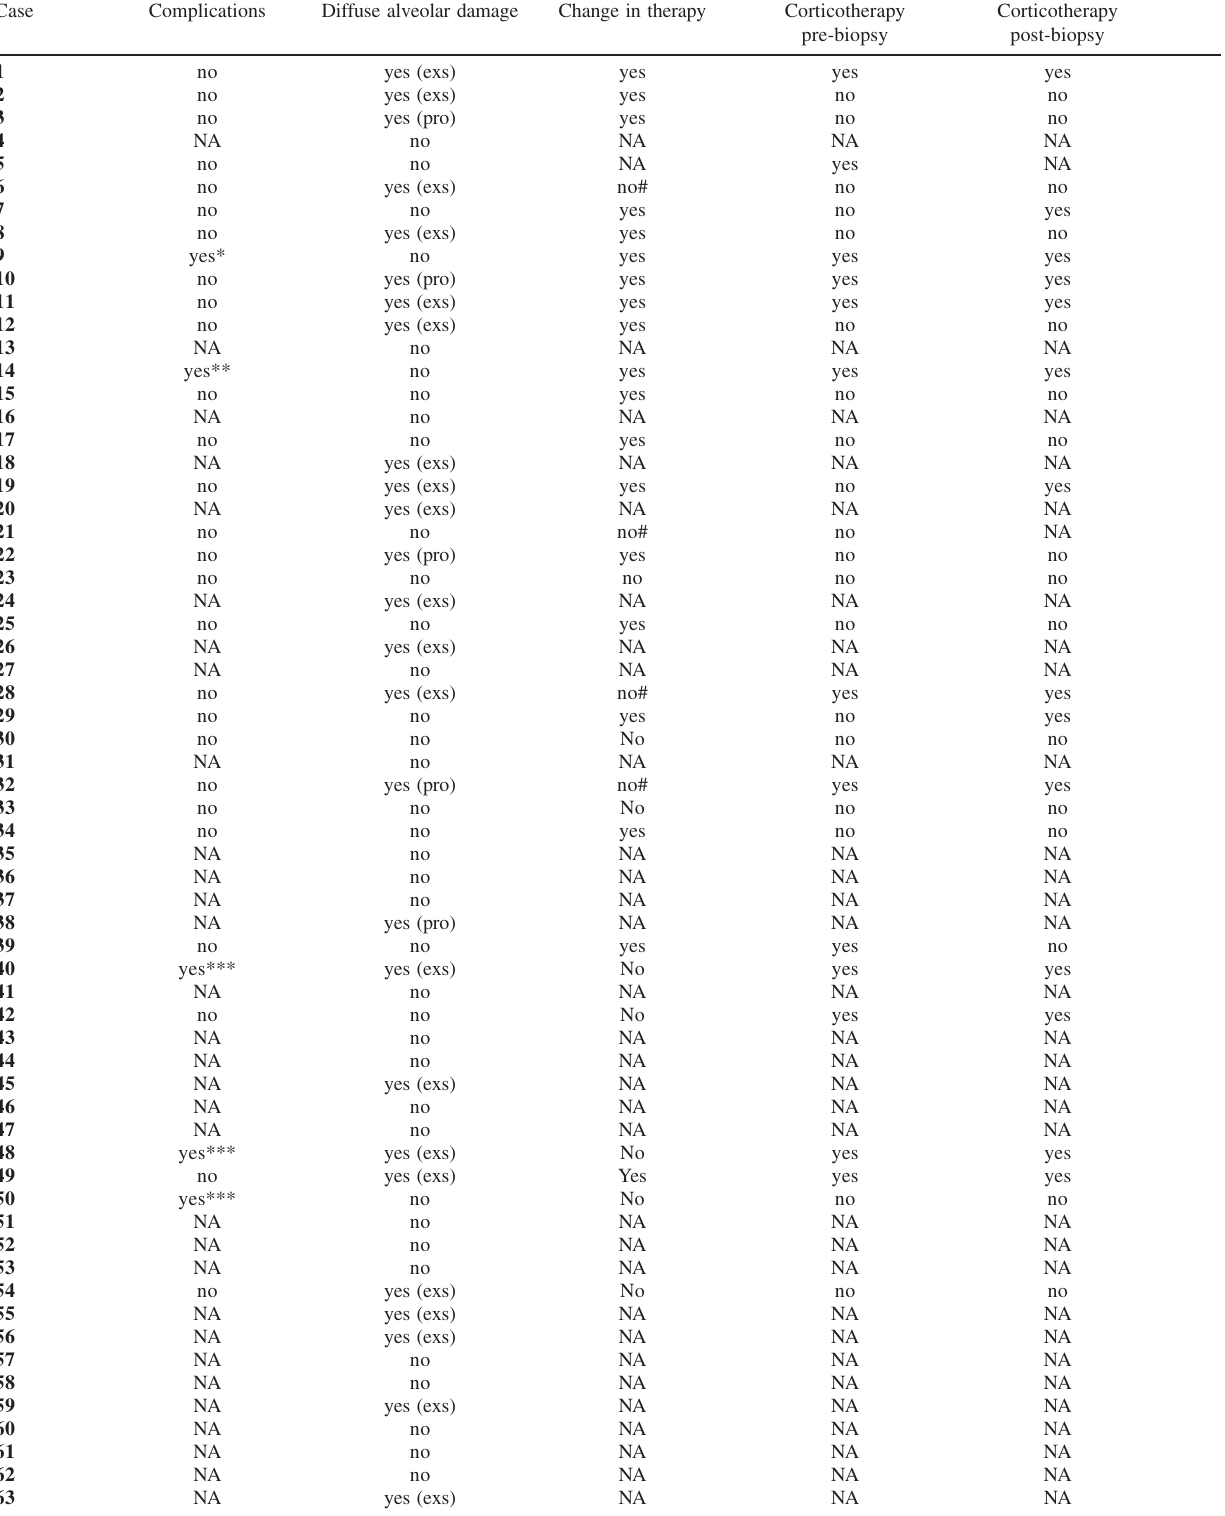
Table 4 - Data concerning complications related to biopsy procedure, change in therapy after histopathological results and corticotherapy before and after histopathological results Case Complications Diffuse alveolar damage Change in therapy Corticotherapy Corticotherapy